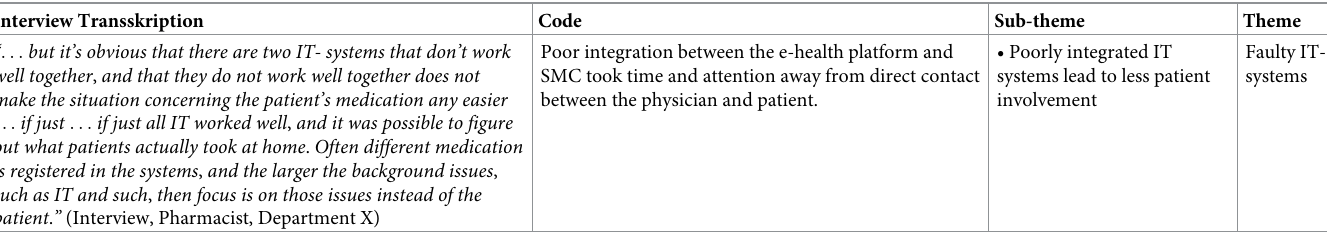
Table 3. Analysis example from interview transcription to